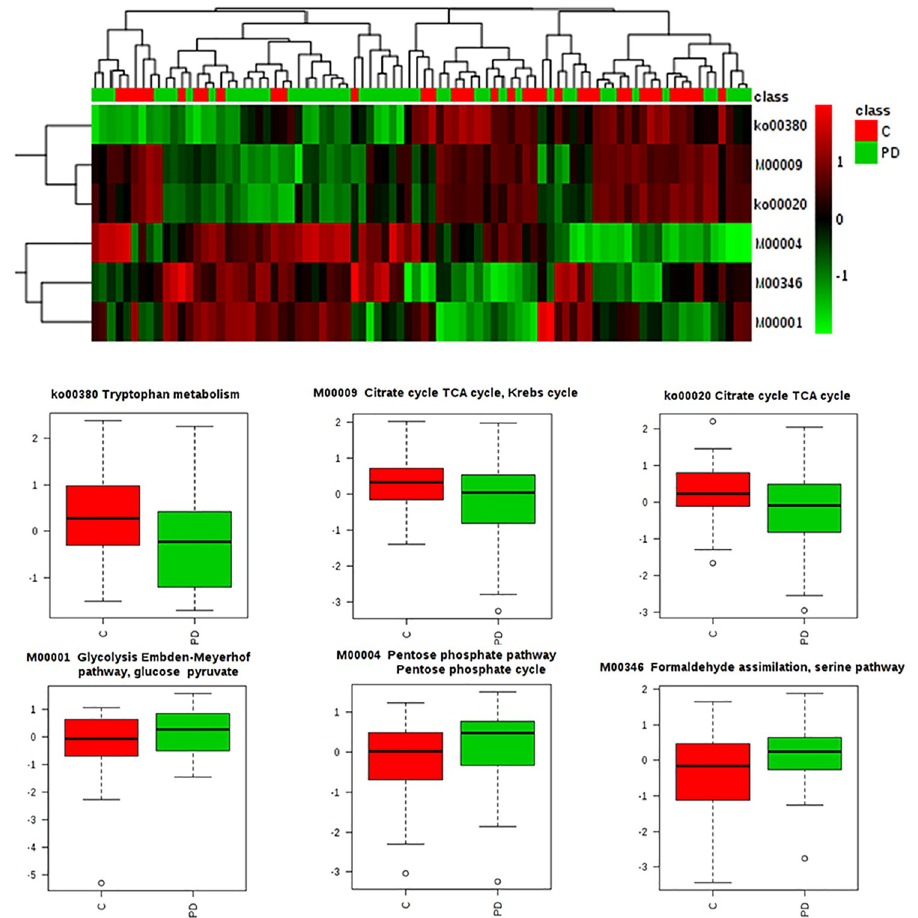
Fig 3. Metabolic pathway changes in oral microbiome of early stage PD. Only 6 of the 167 KEGG pathways were changed when examining transcripts from the oral microbiome in PD subjects compared with controls.